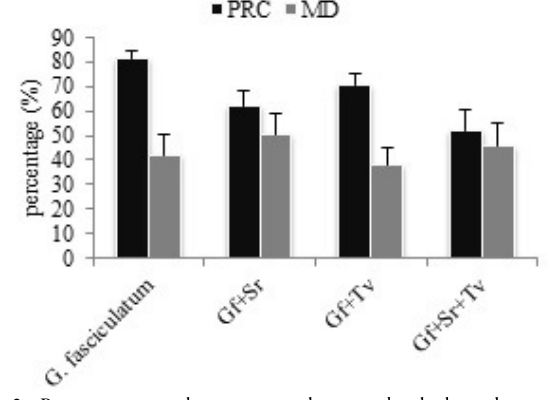
Fig 2. Percent root colonization and mycorrhizal dependency in groundnut (W-51) due to inoculation of G. fasciculatum and T. viride . Mean values (n=3 ± SD). (PRC, percent root colonization; MD, mycorrhizal dependency). Gf+Sr: G. fasciculatum + S. rolfsii , Gf+Tv: G. fasciculatum + T. viride , Gf+Sr+Tv: G. fasciculatum + S. rolfsii + T. Table 1. Growth parameters observed in groundnut (W-51) due to inoculation of G. fasciculatum and T. viride Treatments Leaf (no.)